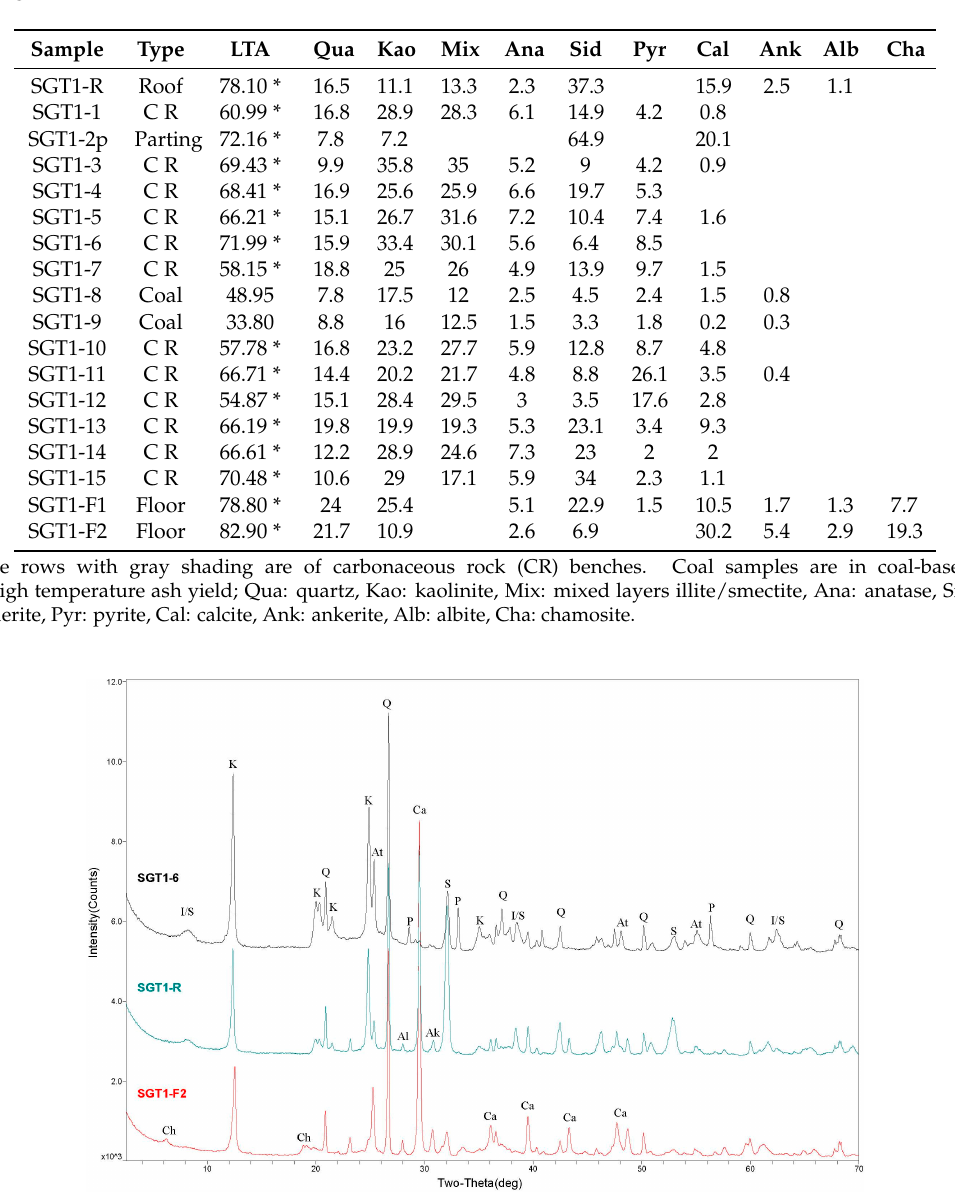
Table 4. Minerals in coal low-temperature ashes (LTAs) and carbonaceous rock, roof and floor of the Shugentian Coalfield (%).